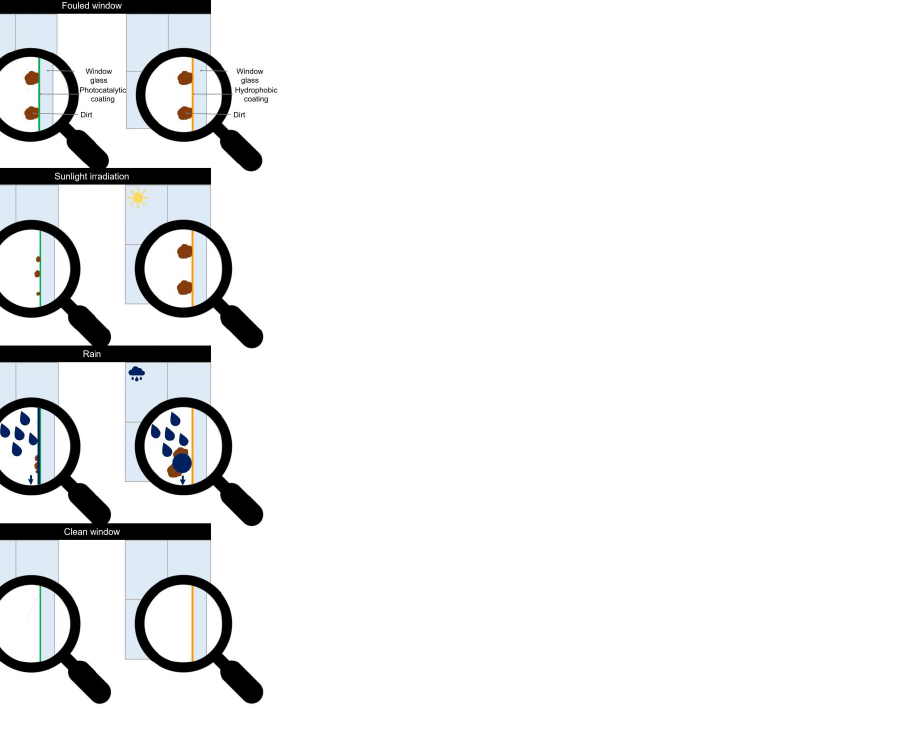
Figure 6. The self-cleaning mechanisms for a photocatalytic, hydrophilic coating on the left and a superhydrophobic coating on the right.